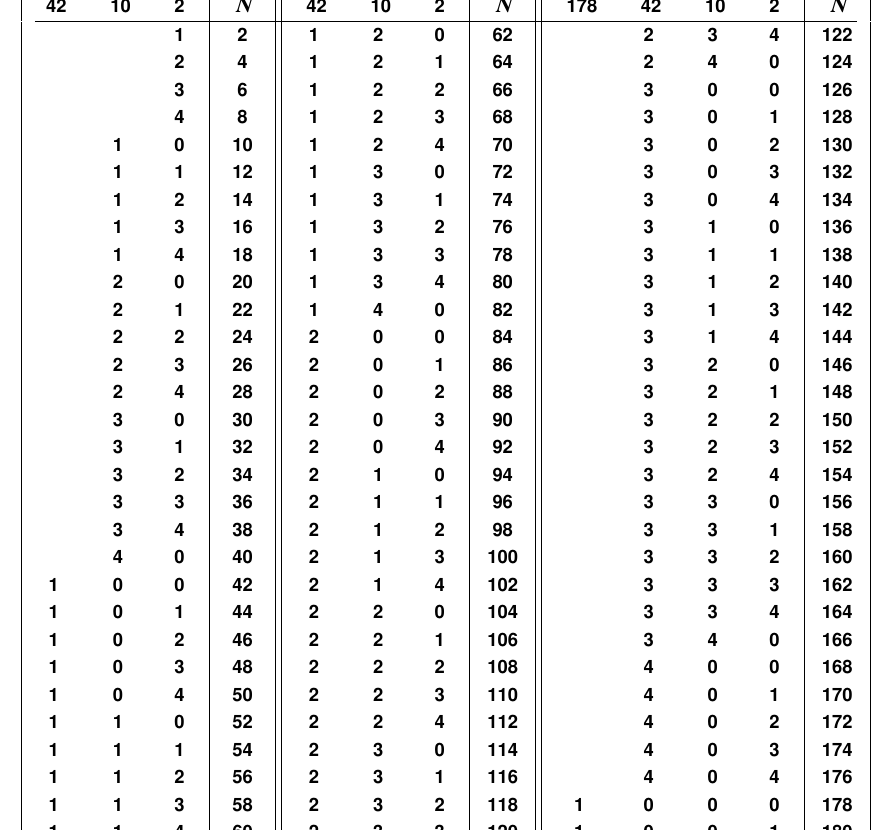
Table 2. Representations R.N/ with N 2 Z even over U